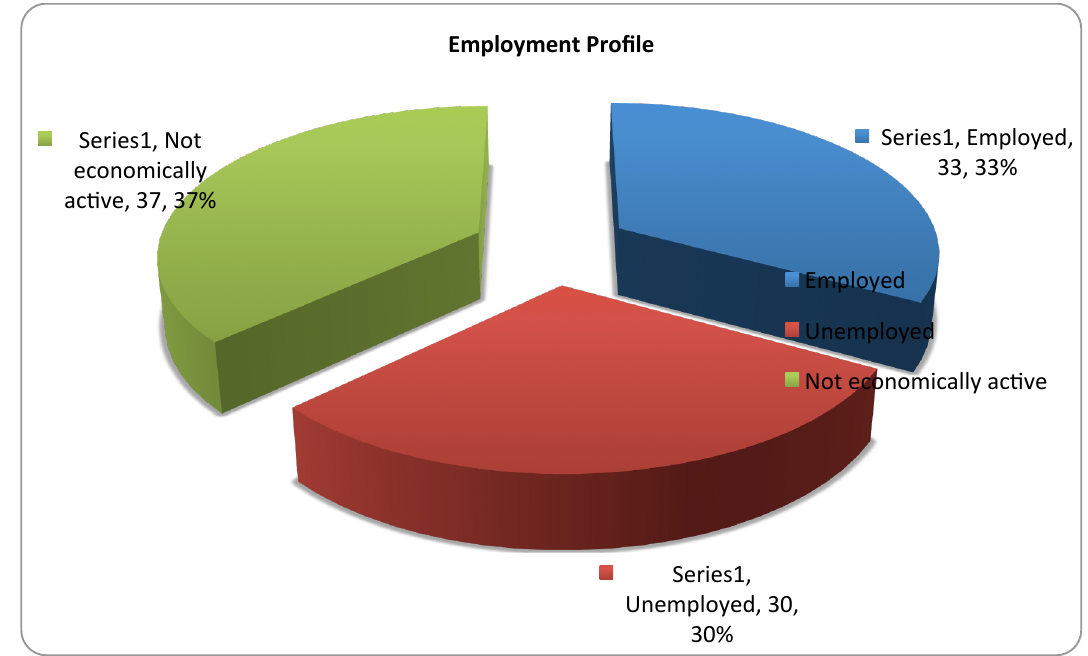
Figure 4 Emfuleni local municipality employment profile (Source: Emfuleni Local Municipality,